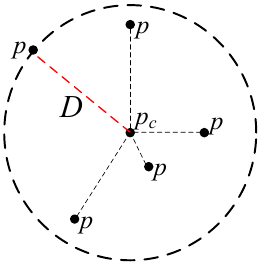
Figure 5. The principle of Degree of Discreteness of Classification Label.